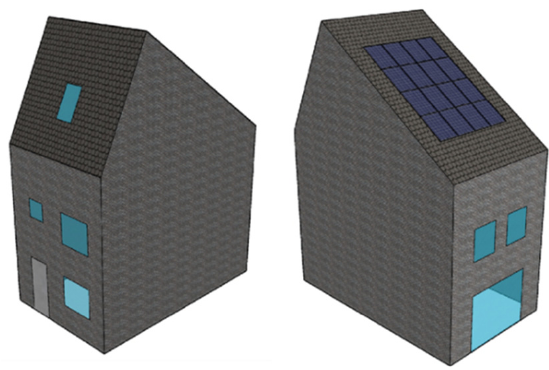
Figure 2. Sketch of the single-family terraced building.